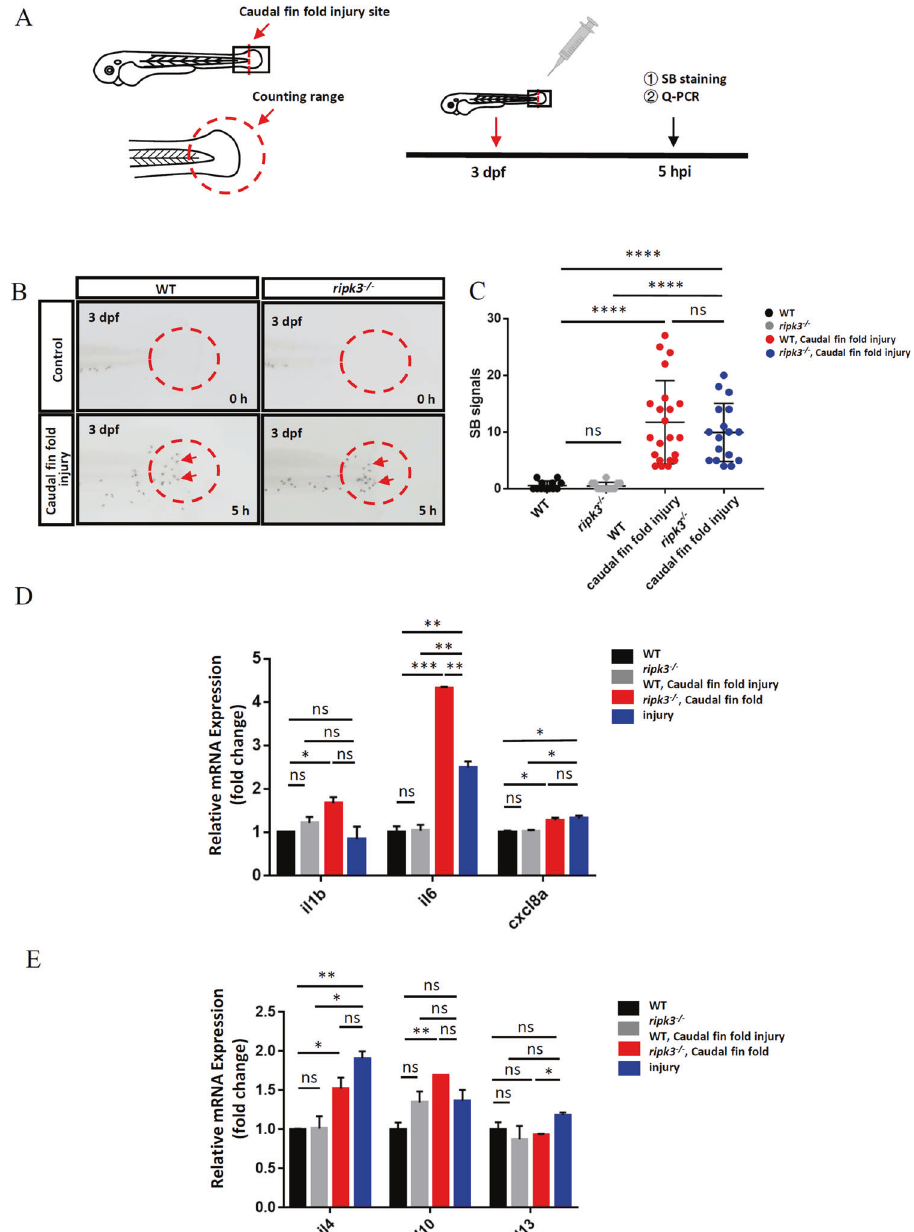
Fig. 4 The ripk3 de fi ciency induced limited changes in non-infectious in fl ammation. A Experimental design. The caudal fi n folds of 3 dpf larvae were injured by sterile syringe needles, and the local accumulation of neutrophils and cytokines expression were detected at 5 hpi. B , C Normal neutrophils attraction towards the injury site. At 0 hpi, few neutrophils could be found in the injury area (red circle). At 5 hpi, similar numbers of neutrophils (red arrows pointed) were attracted to the caudal fi n folds ( n ≥ 12, Student ’ s t -test). D The expression levels of pro-in fl ammatory cytokines ( il1b , il6 , and cxcl8a ) ( n ≥ 10, One-way ANOVA). E The expression levels of anti-in fl ammatory cytokines ( il4 , il10 , and il13 ) ( n ≥ 10, one-way